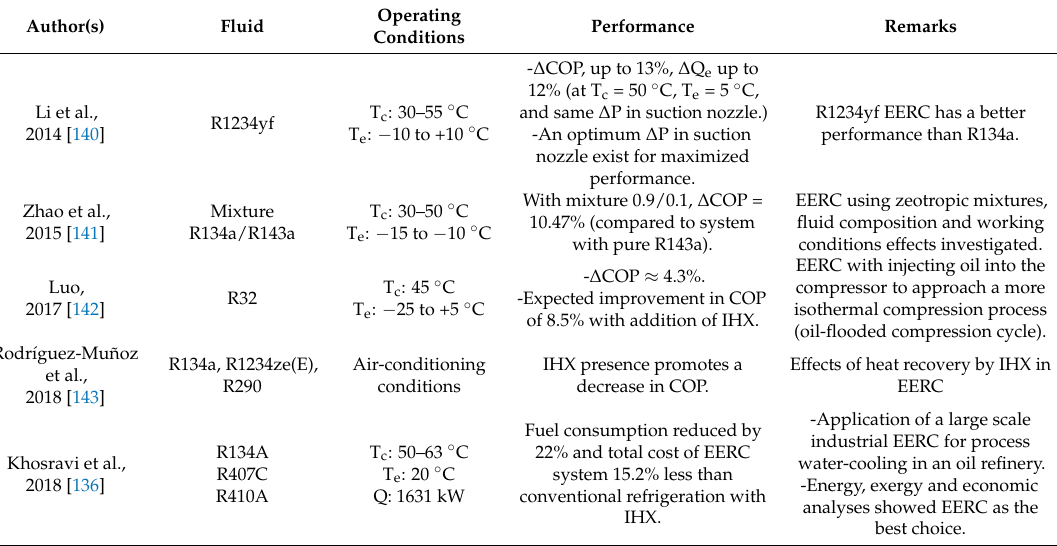
Table 4. Selection of EERC relevant theoretical studies (synthetic refrigerants).